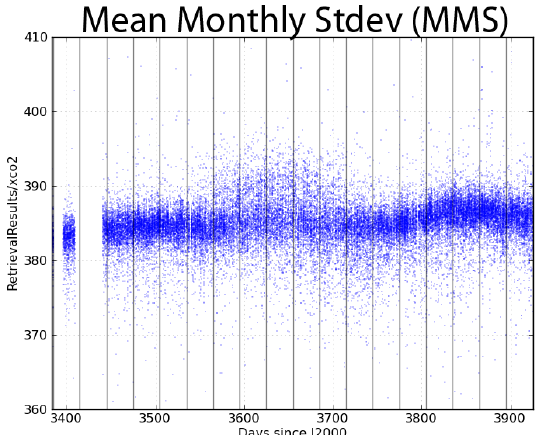
Figure 5. A heat map of the retrieved values of CO2 for the entire southern hemisphere over land is shown. The blue bars identify the monthly bins within which the standard deviation will be taken. The MMS is the mean of each of the standard deviations of these 18 bins.